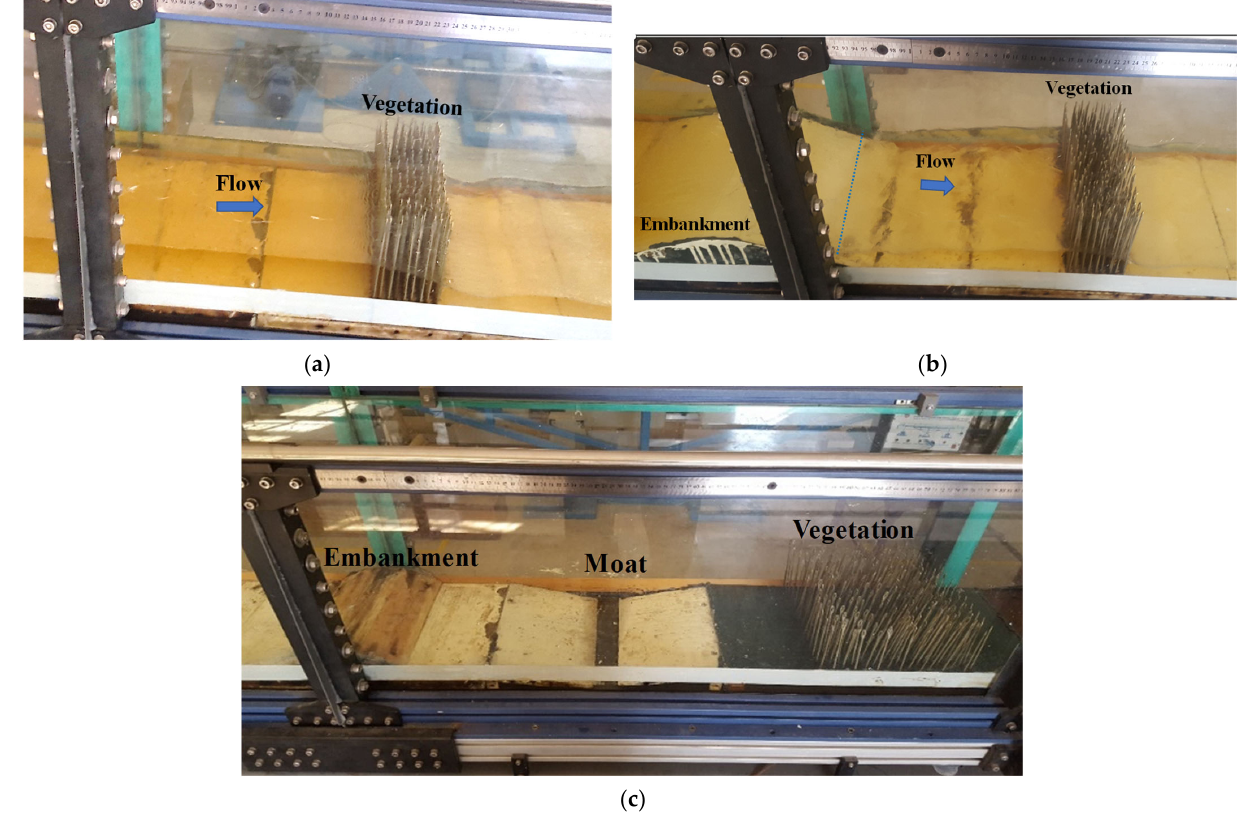
Figure 3. Illustration of the test section of the different experiments assessed herein: ( a ) only vegetation (OV); ( b ) embankment and vegetation (EV) model; ( c ) embankment, moat, and vegetation (EMV) model.